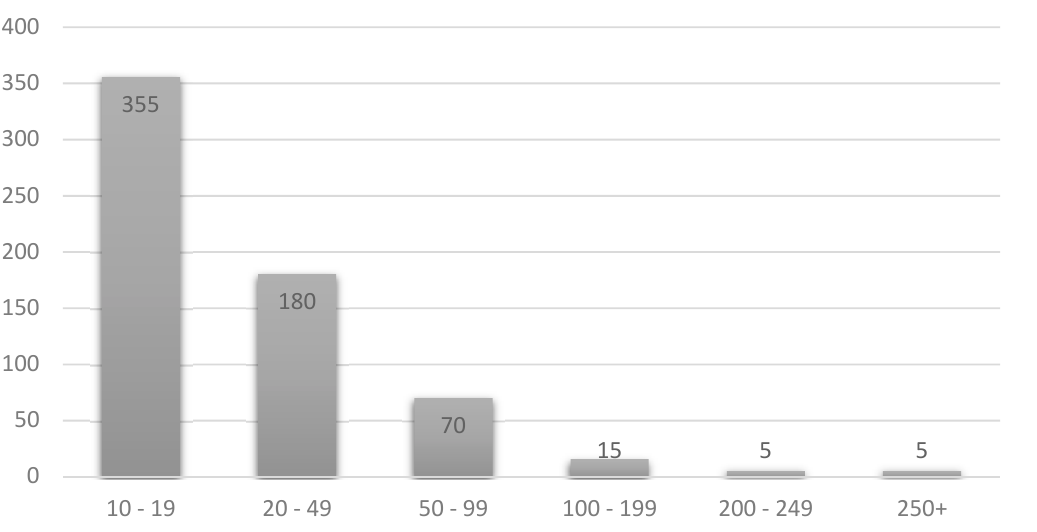
Figure 5. Time impact (delay) of legal challenges.